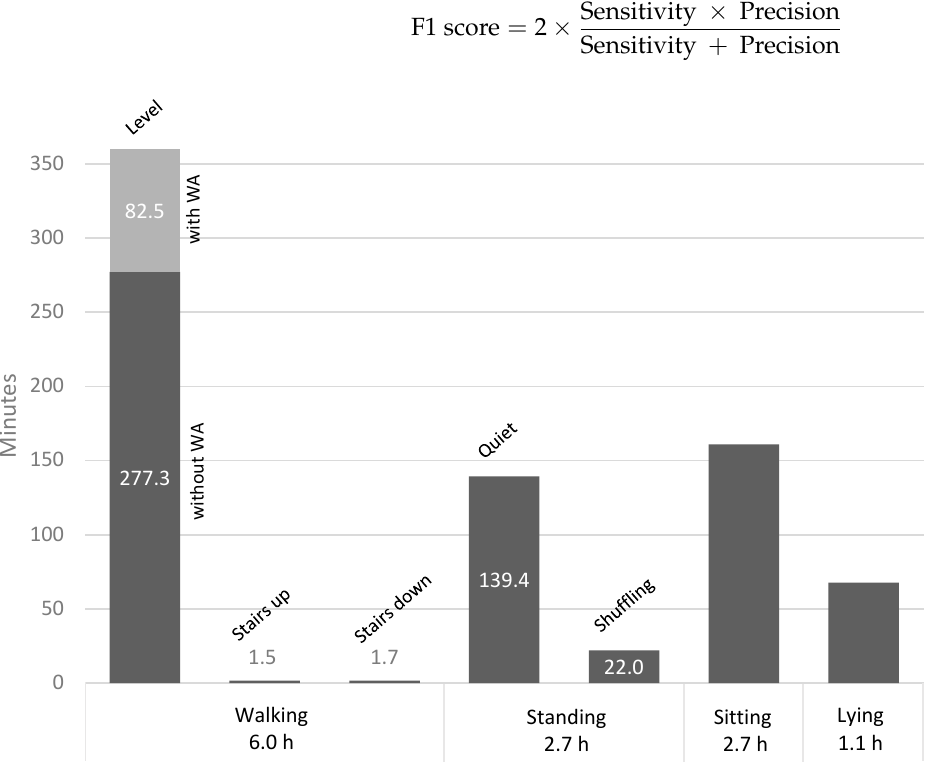
Figure 3. Time distribution of the labeled video data for the activity types during the semi-structured protocol. Light grey color represents the time of level walking with walking aids (WA).